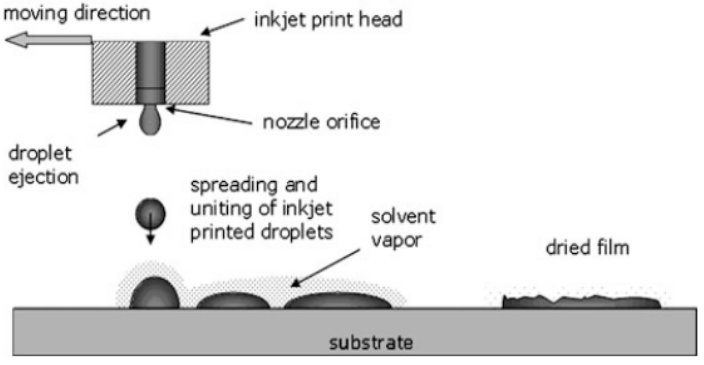
Figure 3. Standard film development by inkjet printing. Reprinted with permission from [14].